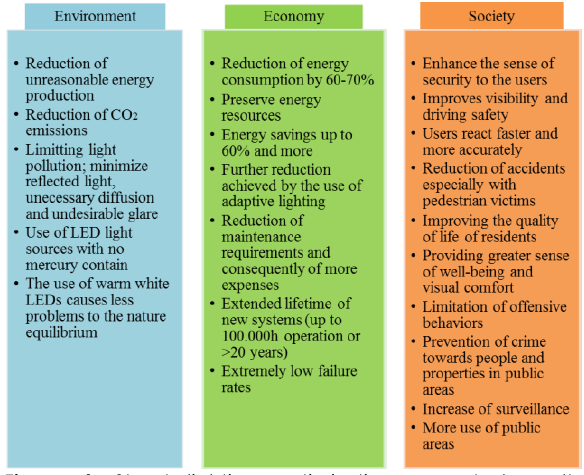
Figure 4. Street lighting optimization expected results (Developed by the Authors) With this background and an